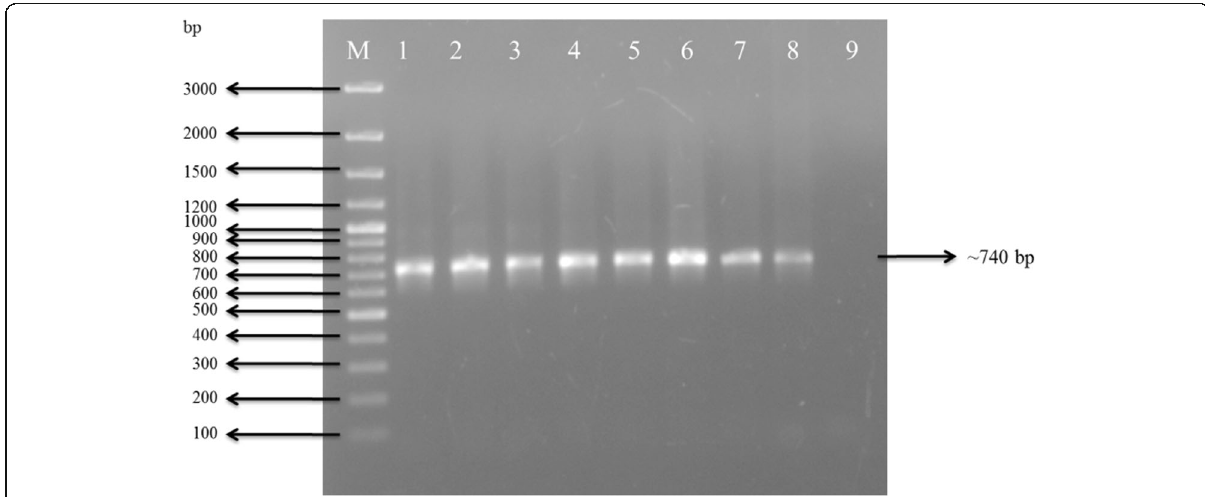
Fig. 1 Electrophoretic profile of polyhedrin gene amplified from total DNA of different geographical isolates of Hear NPV (M: Marker: 100bp ladder (Thermoscientific); Lane 1: Rke-In; 2: Chan-In; 3: Gul-In; 4: Dhl-In; 5: Akl-In; 6: Hyd-In; 7: Udr-In; 8: Hor-In; 9: Non template